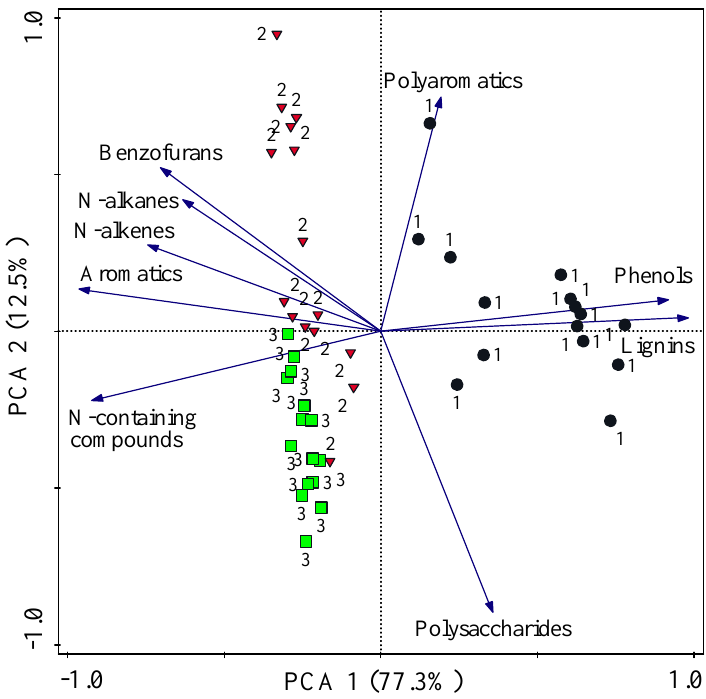
Figure 3. Principal component analysis (PCA) of nine chemical groups in three fractions. Different numbers represent three fractions, 1 for coarse POM, 2 for fine POM and 3 for MAOM, respectively.